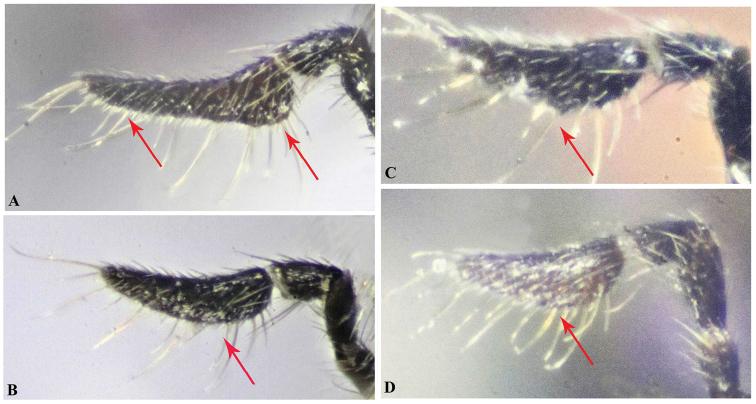
Maxillary palp, Holotype AOodera
arabica sp. nov. BOodera
omanensis sp. nov. COodera
rapuzzii sp. nov. DOodera
similis sp. nov. (apical segment of maxillary palp indicated).